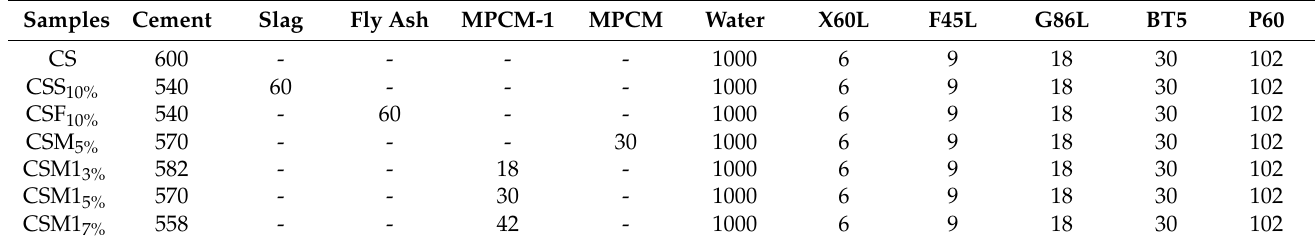
Table 4. Mixture composition of cement slurry system (g).